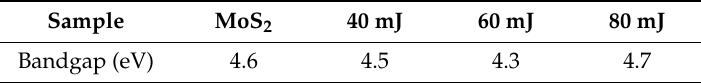
Table 1. Bandgap calculation from Figure 6 (error 0.05